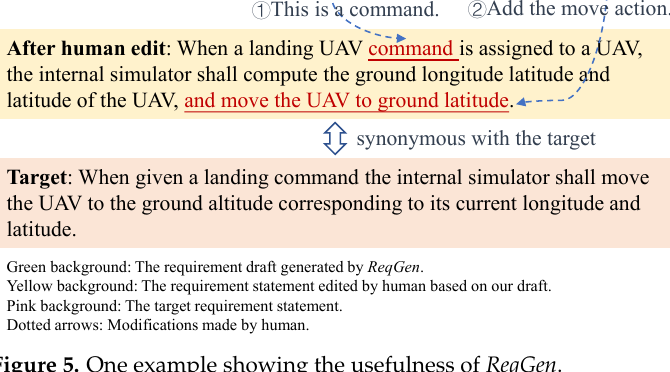
Figure 5. One example showing the usefulness of ReqGen